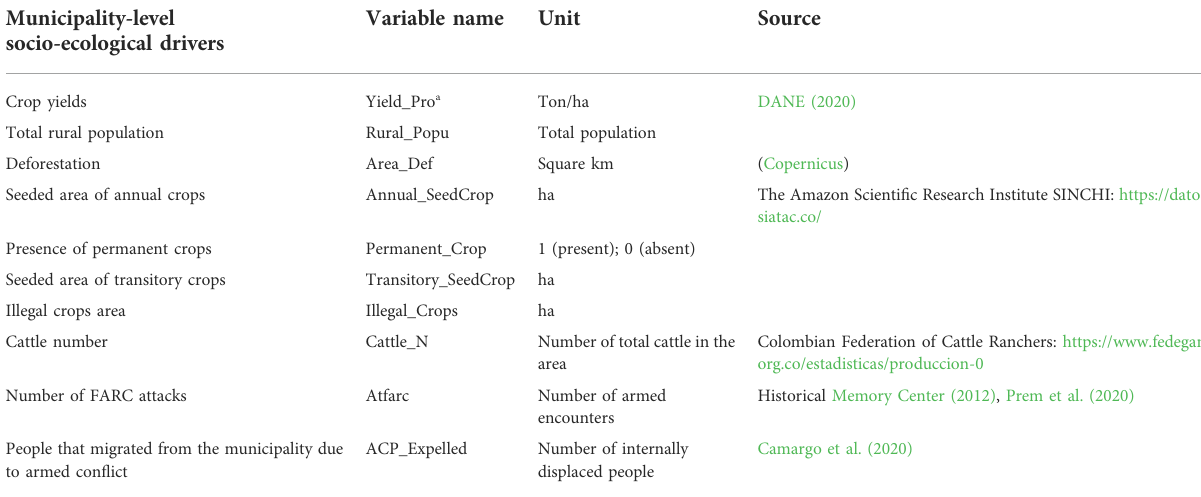
TABLE 3 Municipal-level socio-ecological drivers (i.e., anthropogenic and ecological disturbances) affecting deforestation and carbon storage change in Neotropical forests in central Colombia. Municipality-level socio-ecological